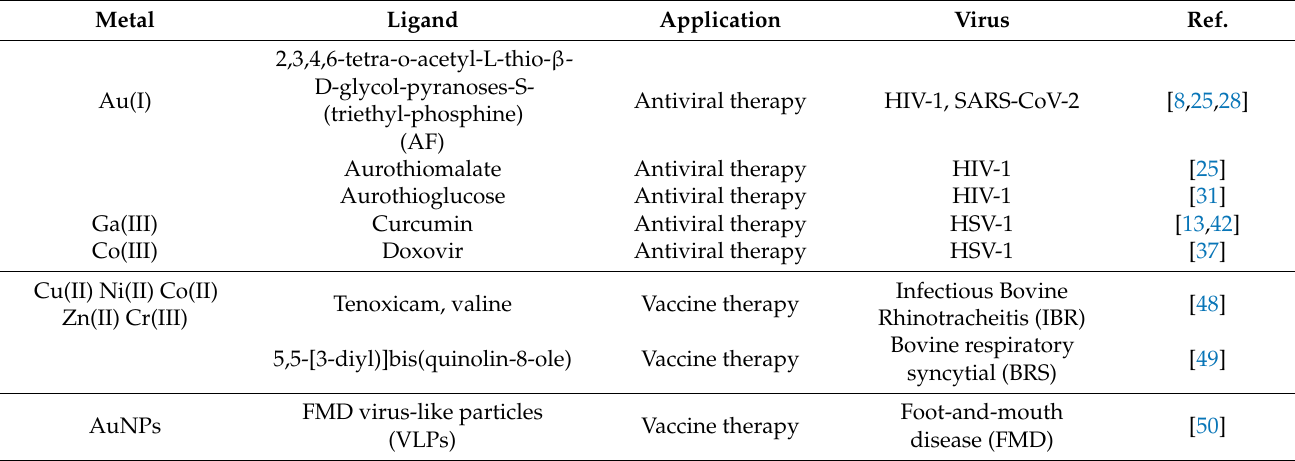
Table 1. Metal complexes and their applications in antiviral